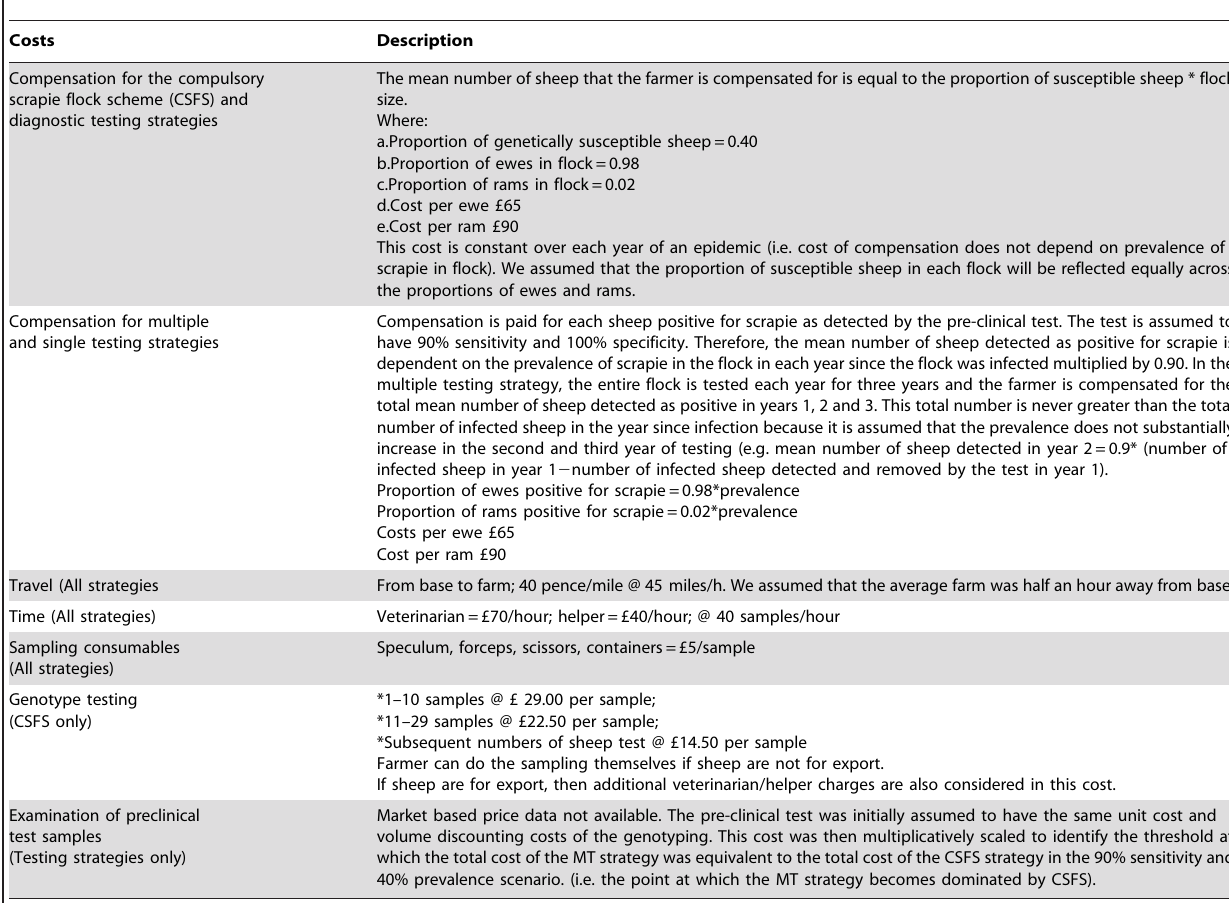
Table 1. Description of costs incurred for Compulsory Scrapie Flock Scheme, single and multiple pre-clinical testing